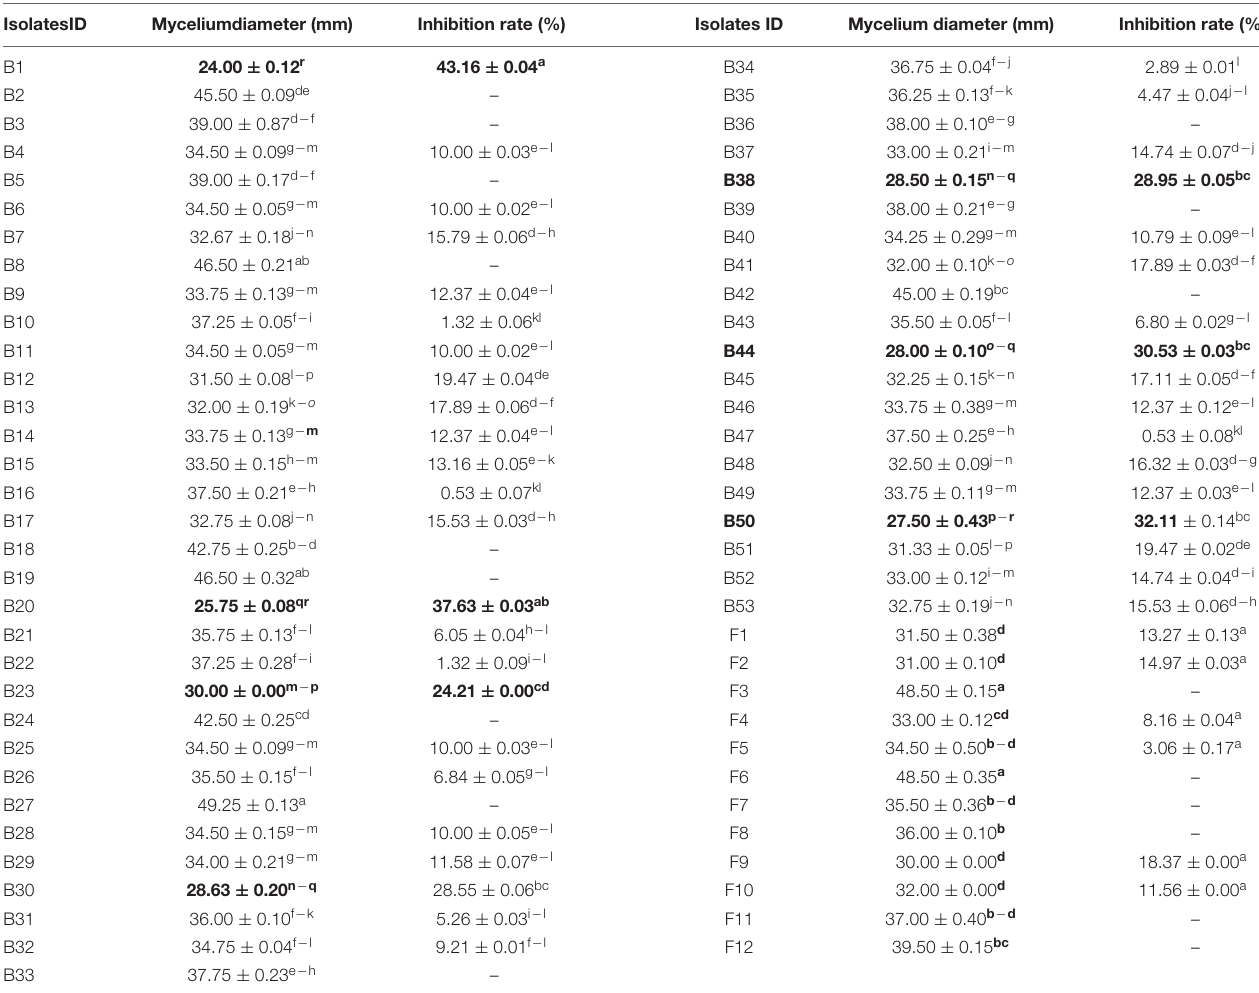
37.75 ± 0.23 e − h – Data are presented as means ± standard deviation. Different letters within each row indicate statistically significant differences (P < 0.05, n = 3) based on Duncan’s tests. The ANOVA of mycelium diameters of bacteria and fungi were analyzedseparately. “–” indicates no antifungal activity. Antifungal activity of the seven bacterial strains with the highest antagonistic ability are